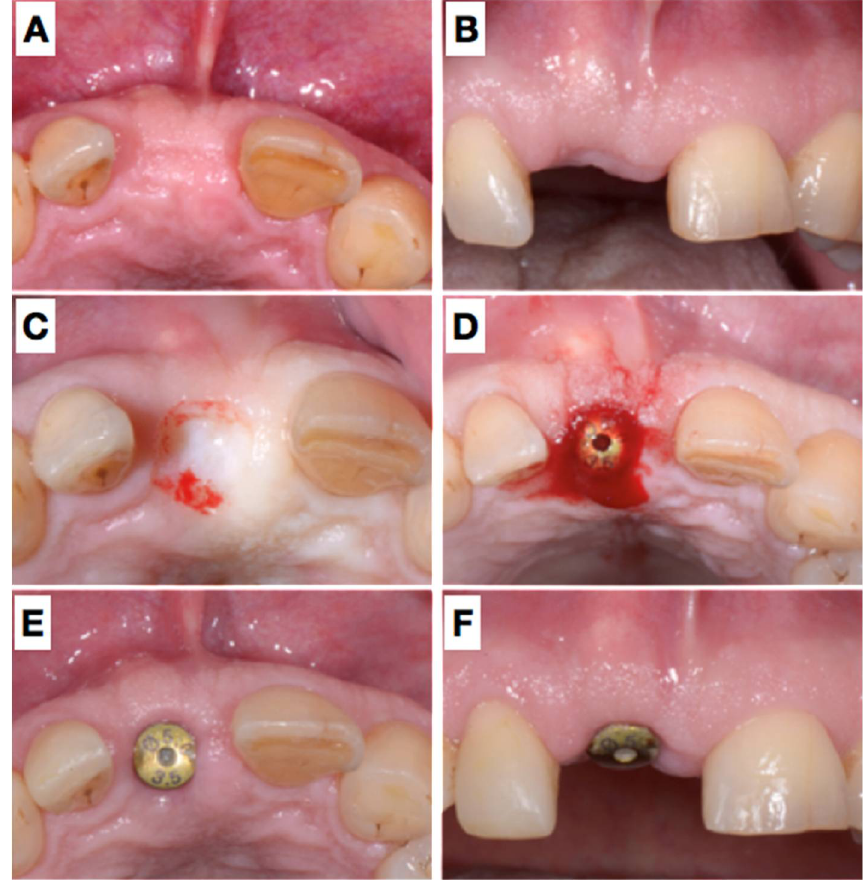
Figure 4. After 6 months submerged healing of the implant ( A , B ), the mucosa was de-epithelialized ( C ) and a roll-flap was made to uncover the implant ( D ); a healing cap was placed, which held the buccally advance flap in situ. Situation after 3 weeks ( E , F ).